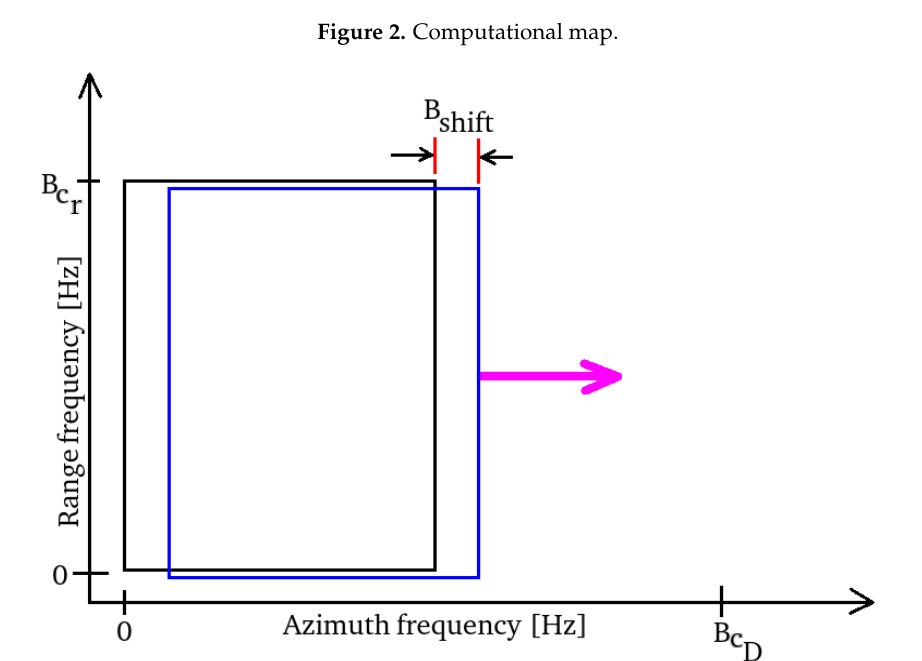
Figure 3. Bandwidth allocation